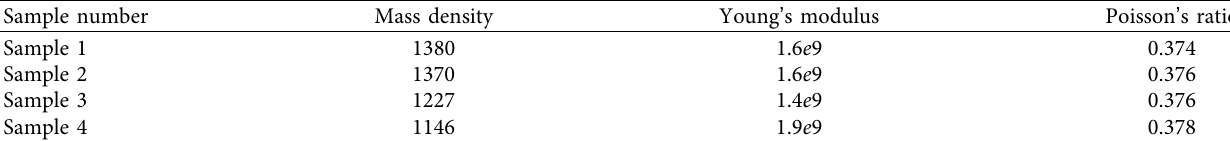
Table 2: Ball line calculation parameters of four badminton rackets.